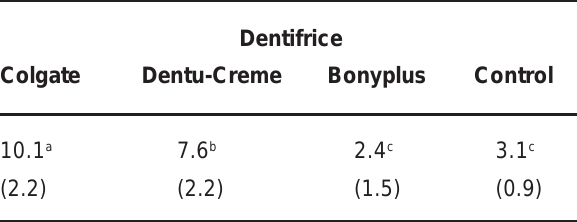
TABLE 4- Weight loss of the artificial teeth promoted by the dentifrices used in this study (mean±standard deviation)